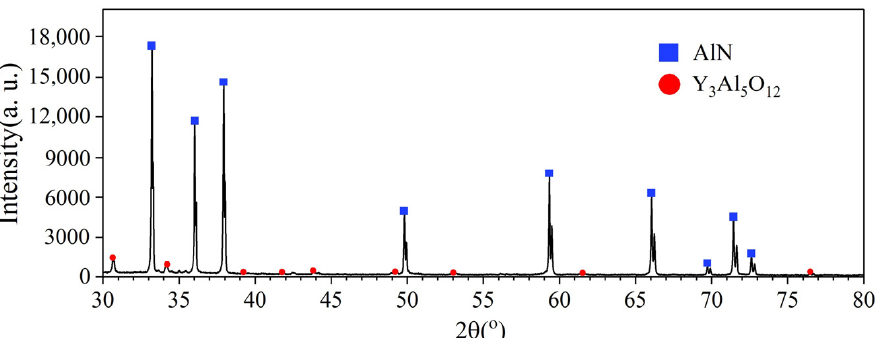
Figure 2. X-ray diffraction (XRD) spectrum of AlN ceramics.